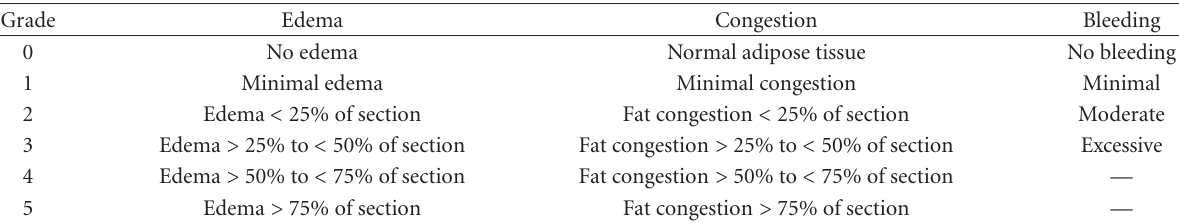
Table 1. Scales for edema and congestion in flap adipose